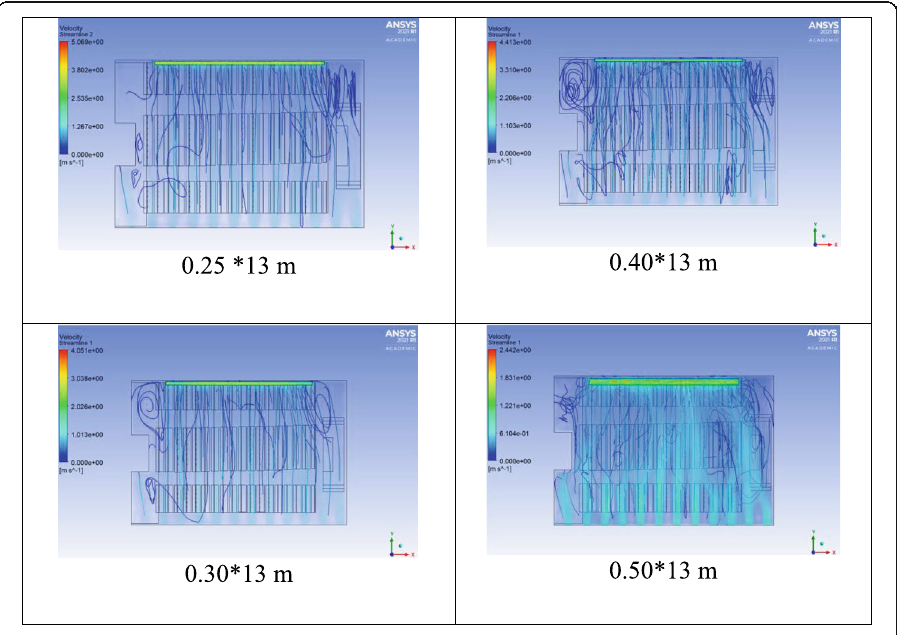
Fig. 14 Stream line air velocity for the rectangular cross-section at the breathing level zone (1.2 m), output from the ANSYS CFD model